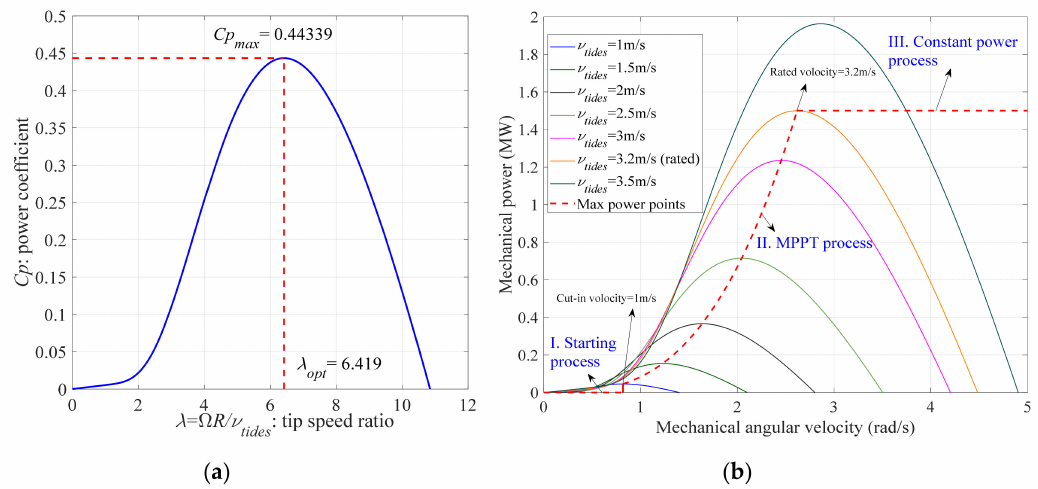
Figure 2. Characteristics of tidal current turbine: ( a ) Cp curve, ( b ) P - Ω curves under various